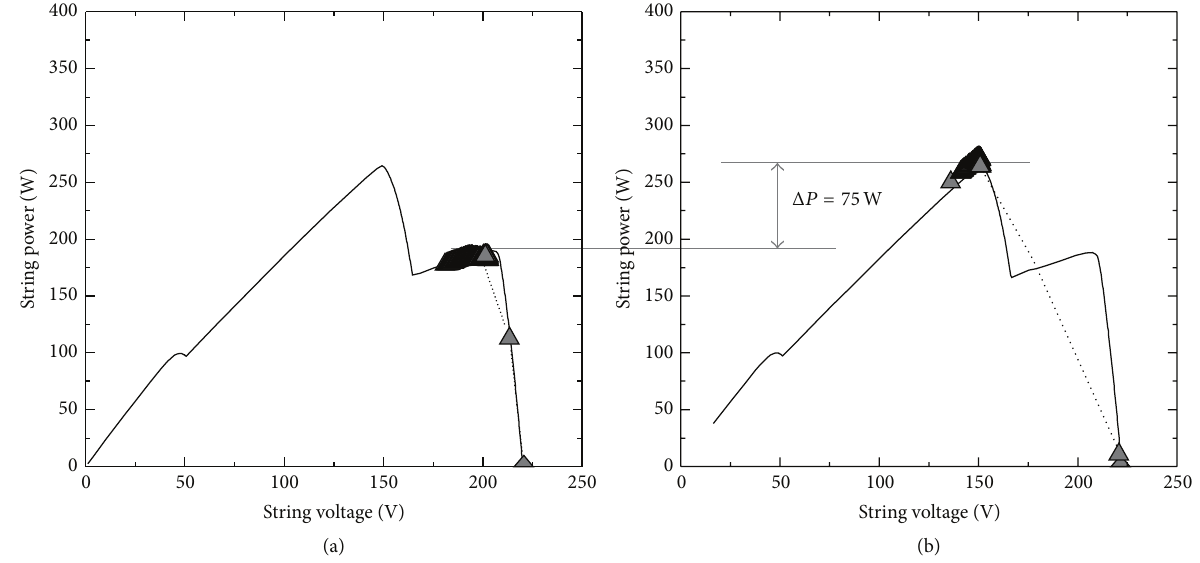
Figure15:Algorithmscomparison.Thetrackingperformancecorrespondingtothecommercialinverter(a)andtheinformationbasedMPPT (b) are compared. The operating points (triangle) over the P-V curves (solid lines) are reported.